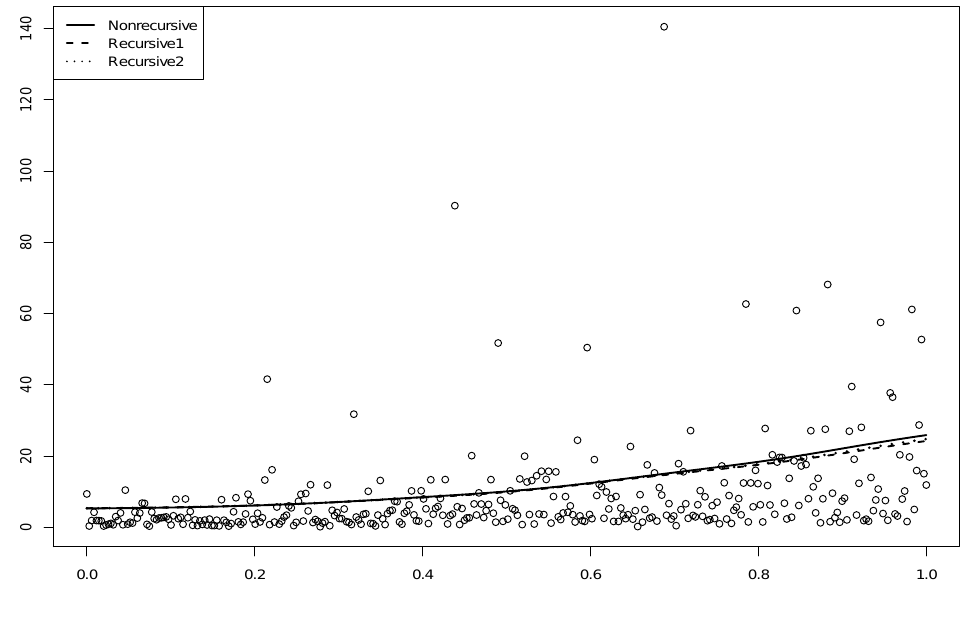
h k (cid:3)(cid:1) using model 1; µ ( X ) = 0.5 + 2 x , k =1